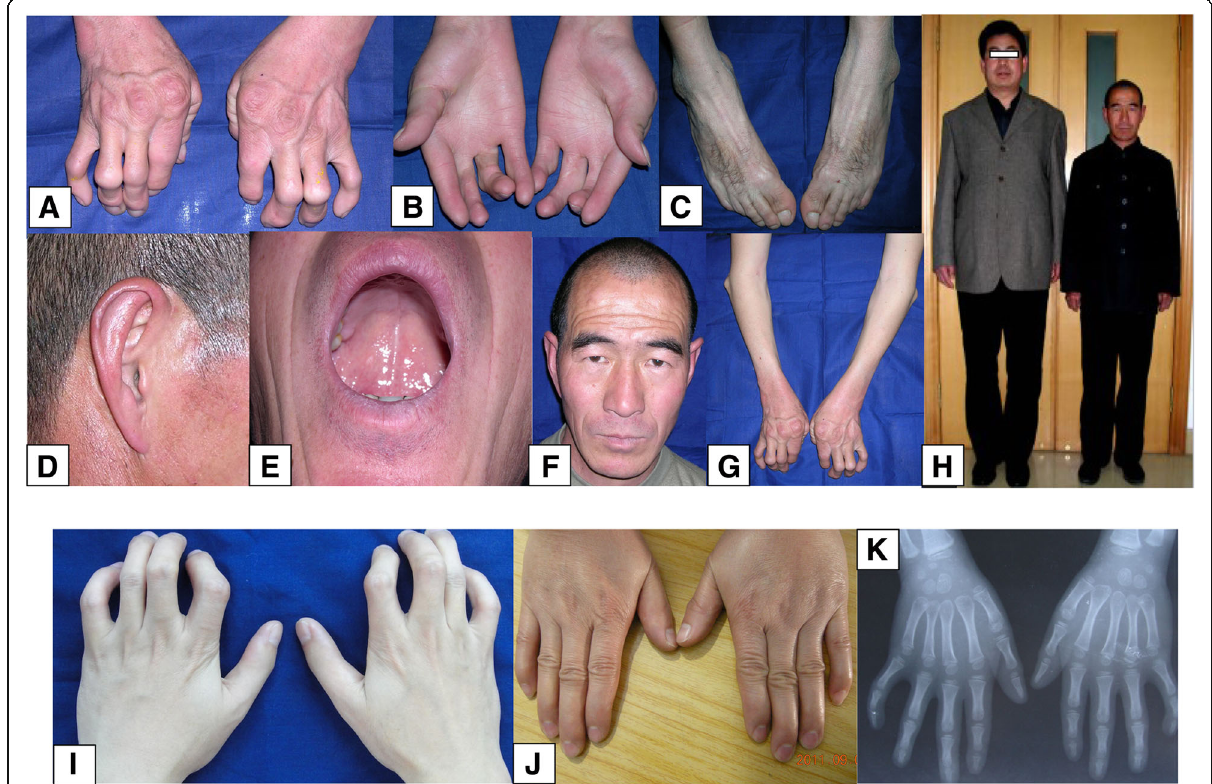
Fig. 2 Clinical features of patients in Family 1 with DA2B ( a - h ) and Family 2 with mild DA ( i - k ). a Ulnar deviation and contractures in patient II5. b Camptodactyly and adducted thumbs in patient III1. c Flexed toes and talipes equinovarus in patient II5. d Dysplastic ear and attached ear lobes in patient II5. e Small mouth with limited opening in patient II5. f Downward-slanting palpebral fissures, a small chin, and deep folds in the nasolabial area and forehead in patient II5. g Flexion contracture yielding stiff elbows in patient II5. h Short stature of patient II5 (unaffected II6 [left], 178 cm; patient II5 [right], 156.5 cm). i Camptodactyly and ulnar deviation in patient II5. j Mild contractures of the fingers in patient II2. k X-ray findings